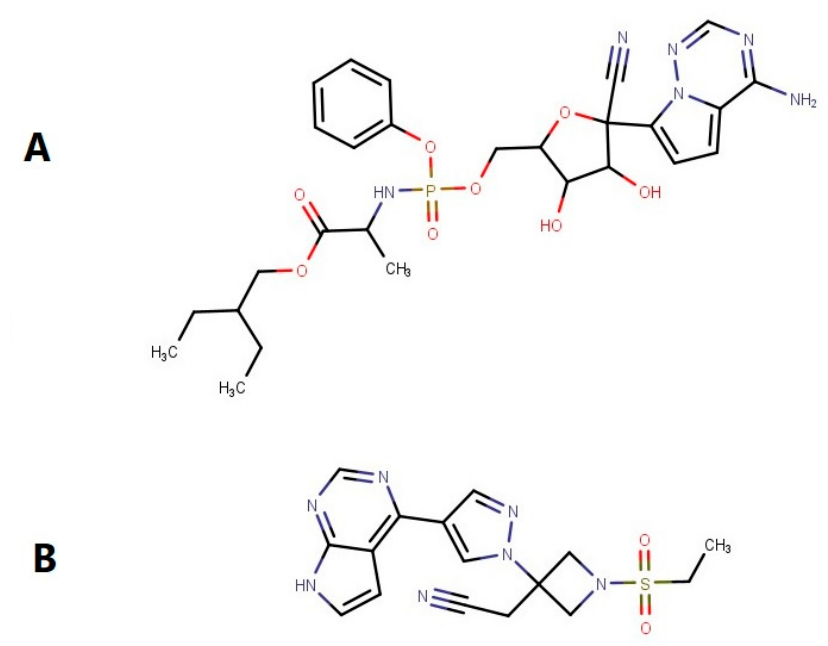
Figure 1. Chemical structure of ( A ) Remdesivir and ( B ) Baricitinib. MarvinSketch was used for drawing, displaying and characterizing chemical structures, MarvinSketch 21.18.0, ChemAxon (https://www.chemaxon.com (accessed on 10 October